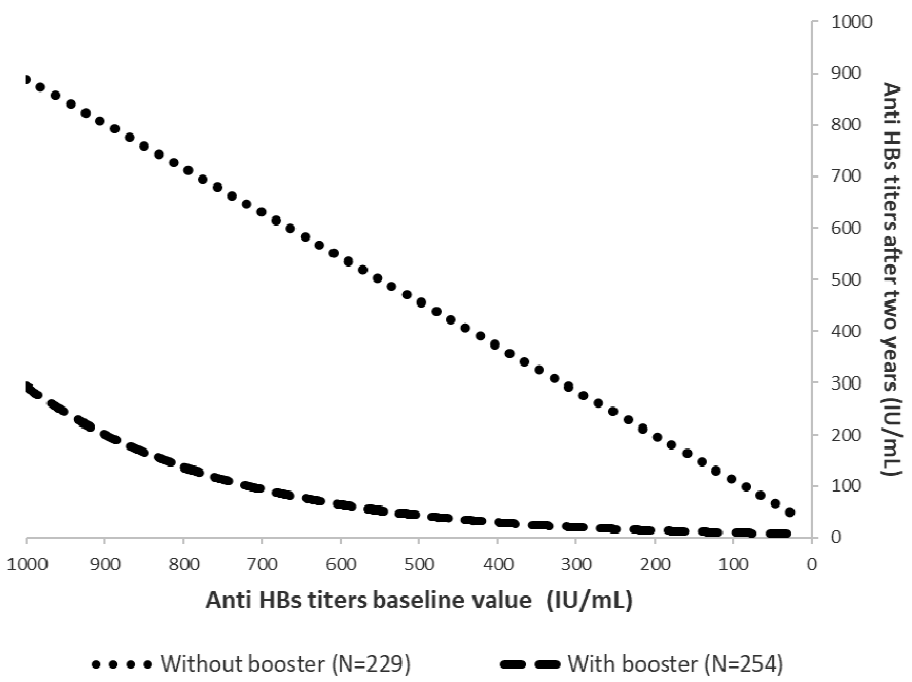
Figure 4. Modelled values of anti-HBs titers after two-year follow-up in students who received and those who did not receive a booster vaccination (values have been calculated according to the predictive function observed starting from an arbitrary value of 1000 mIU/mL).